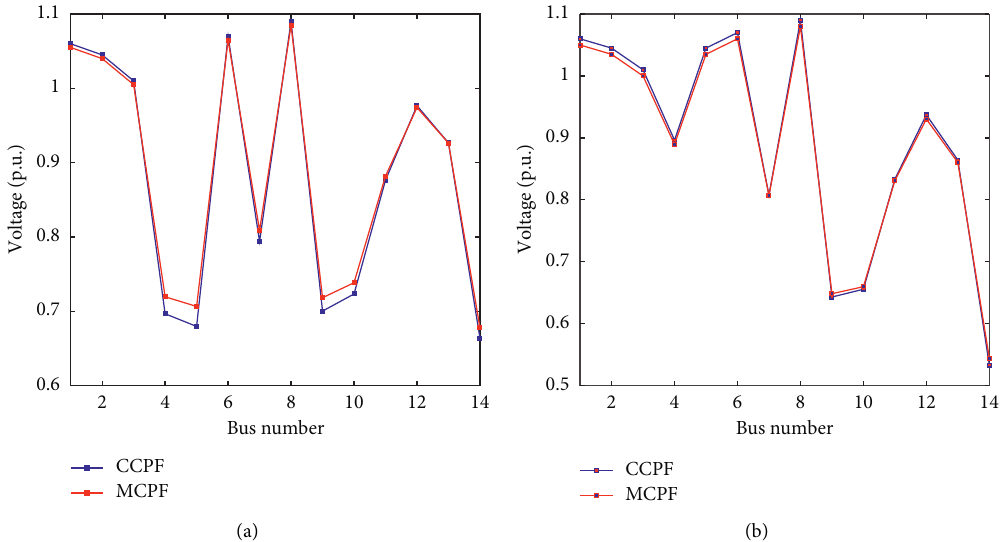
Figure 5: Voltage profile of 14-bus system: (a) without DG; (b) with DG.